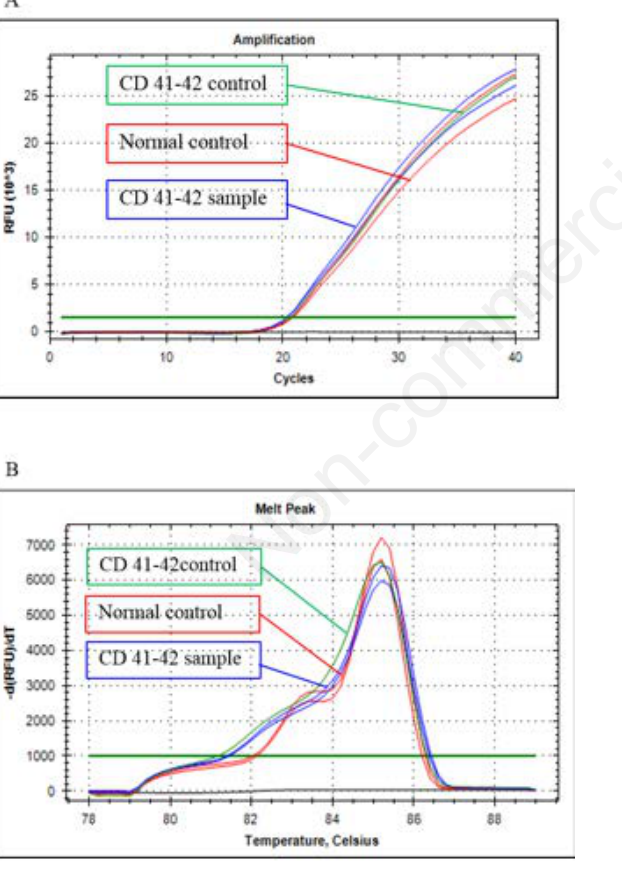
Figure 2. Chromatograms A and B are HRM analysis images that show a definite different pattern between wild-type and mutant products. Of the mutant products, the unknown melting profiles are in alignment with the genetically demonstrated CD 41-42 mutant, which suggests that the unknown mutant is a CD 41-42